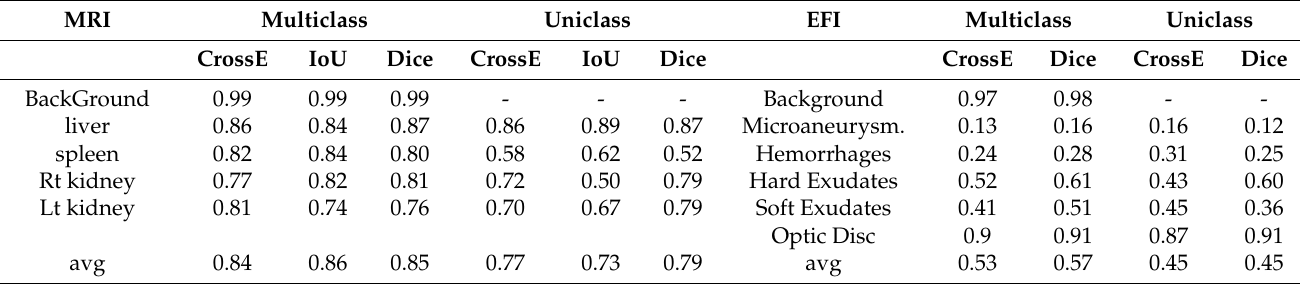
Table 6. IoU achieved with multiclass vs. uniclass on MRI and